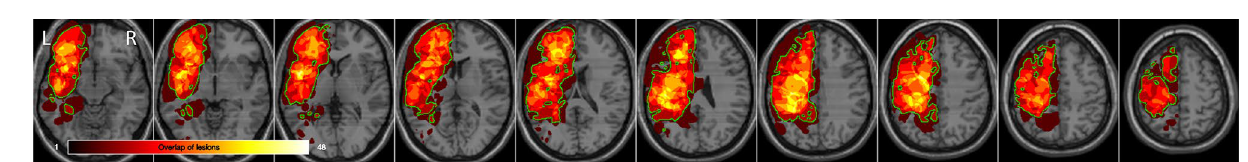
Figure 3. Operationalization of the word finding subtest of the QAB (WordFind) using four computerized language tasks: picture naming (PN), text reading (TR), auditory naming (AN), and syntax formation (Syn). a correlogram summarizing the results of univariate generalized linear models fitted to each language task and WordFind. Color bar represents each correlation coefficient and crosses indicate non-significant associations ( P > 0.05) after corrections for multiple comparisons. b biplot between principal component 1 and 2 (PC1 and PC2) derived from principal components analysis (PCA) on WordFind and the four language tasks. Corresponding loadings are represented by the red arrows.